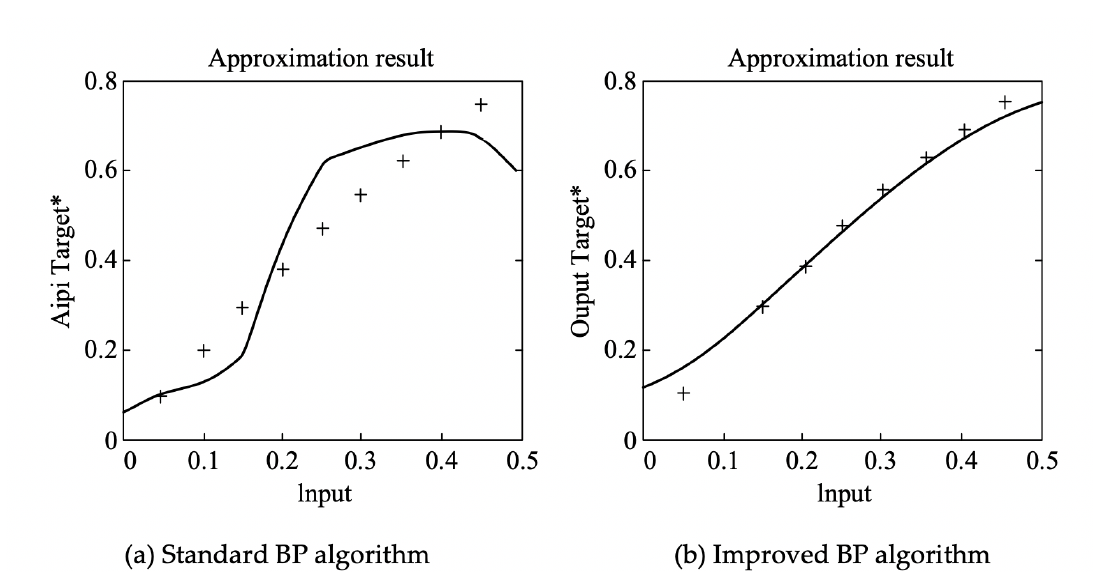
Fig. 3. THE FUNCTION APPROXIMATION EFFECT DIAGRAM OF THE STANDARD BP ALGORITHM AND THE IMPROVED